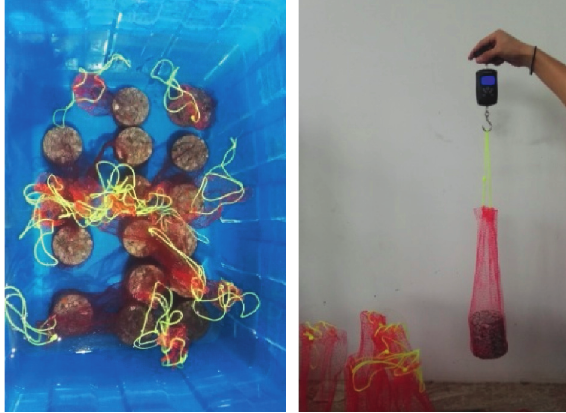
Figure 3: A new method of measuring porosity.